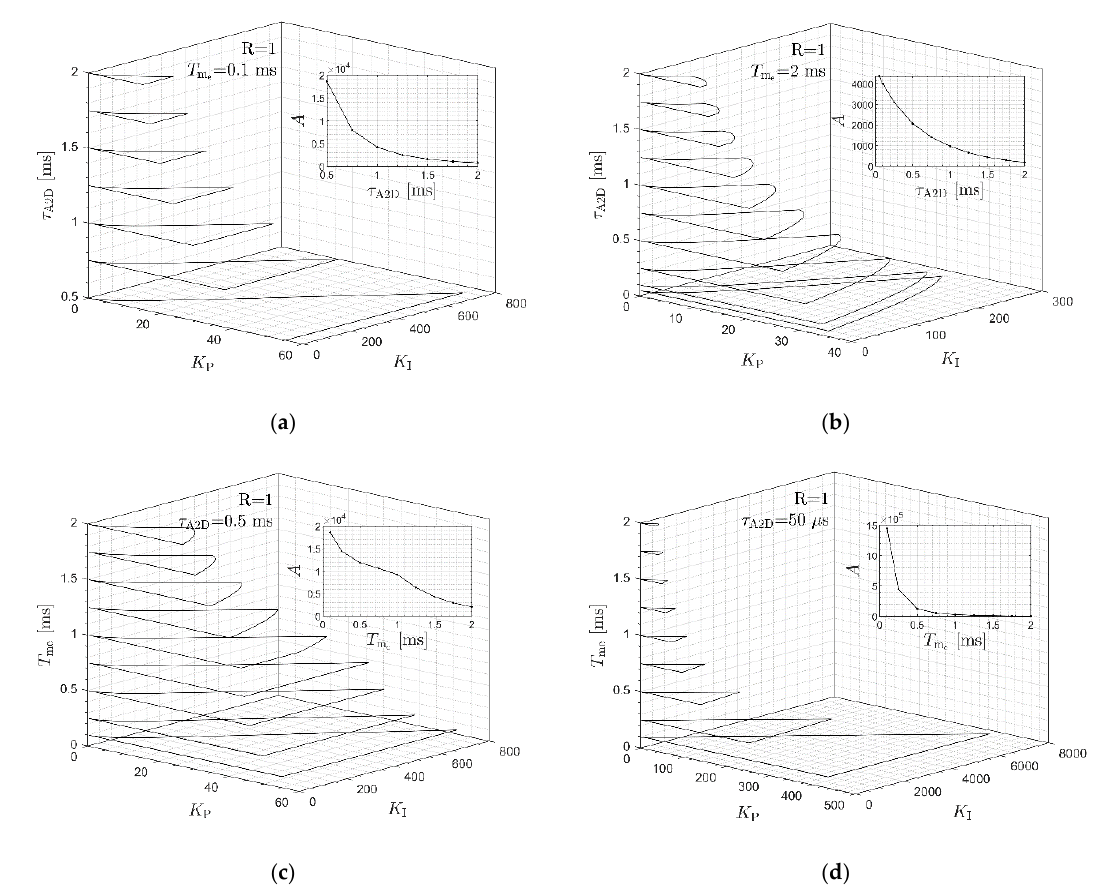
Figure 10. Visualisation of the 𝐾 P and 𝐾 I regions for desired values of 𝐺𝑀 = 20 𝑑𝐵 and 𝑃𝑀 = 70° for the control structure from Figure 2 calculated using D-decomposition technique. Results were obtained for the value of inertia ratio 𝑅 = 1 , time constant of the elastic shaft, 𝑇 C = 2.6 ms, and value of electromagnetic torque time constant 𝑇 m = 0.1 ms ( a ) and 𝑇 m = 2 ms ( b ) and delay from analog-to-digital conversion in the speed sensor 𝜏 A2D = 0.5 ms ( c ) and 𝜏 A2D = 50 µs ( d ). Additionally, the total area, 𝐴 , of obtained regions was presented.